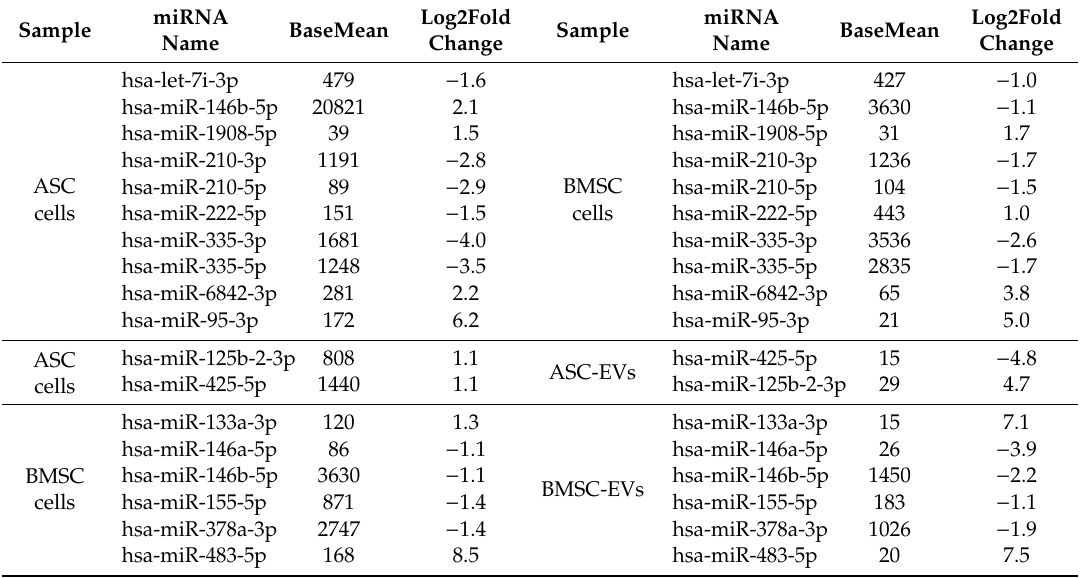
Table 1. miRNAs showing di ff erential expression upon osteoblastogenic di ff erentiation (D7 vs. D0). Sample